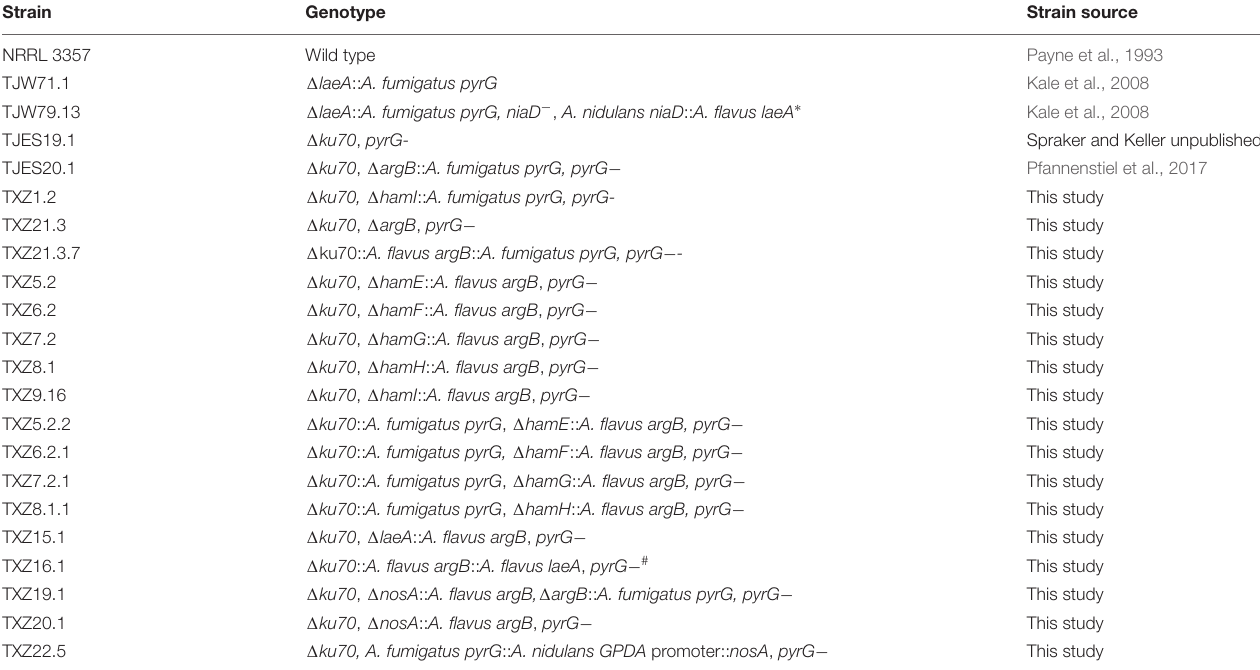
TABLE 1 | Aspergillus flavus strains used in this research and their genotypes. Strain